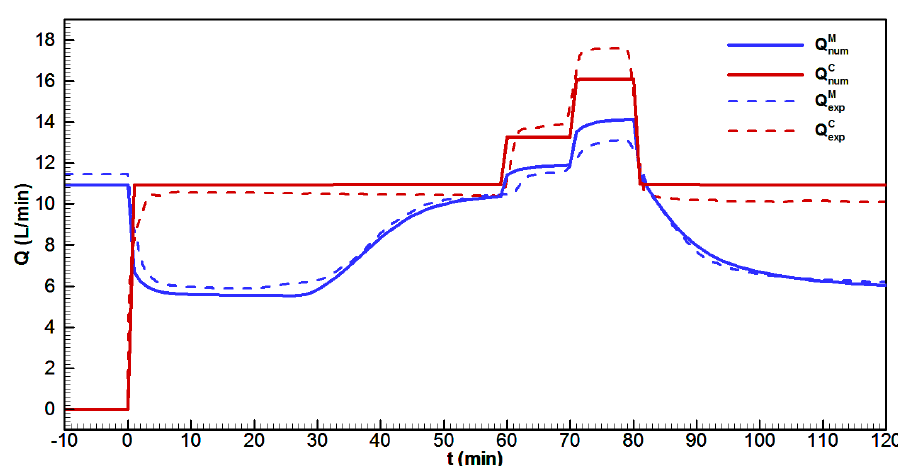
Figure 9. Hydrograph: Experimental (dashed line) and numerical (solid line) results for matrix (M—blue line) and conduit discharge (C—red line), respectively.